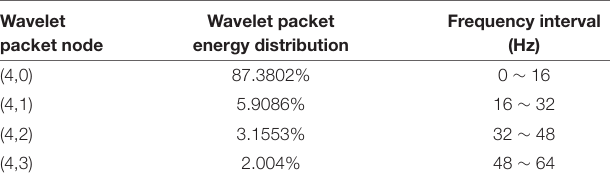
TABLE 1 | The 4-layer wavelet packet decomposition frequency intervals and energy ratio. Wavelet packet